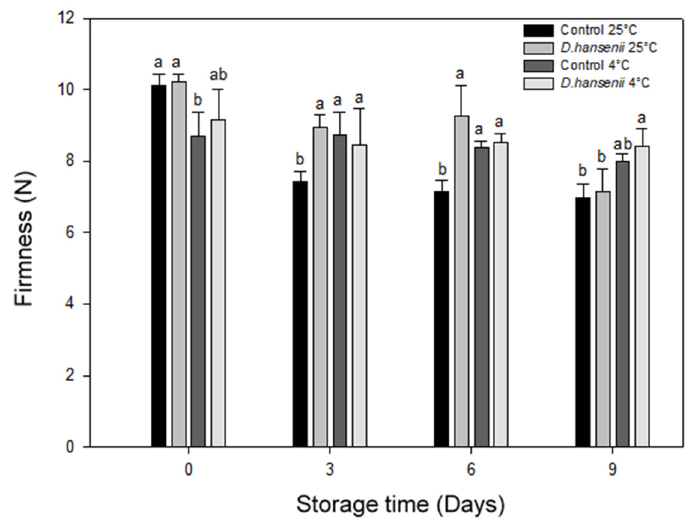
Figure 6. The firmness of blueberry fruits stored at 25 °C and 4 °C under the application of D. hansenii . Values are expressed as mean ± standard error. Different letters in the bars indicate significant differences between treatments at ( p < 0.05).